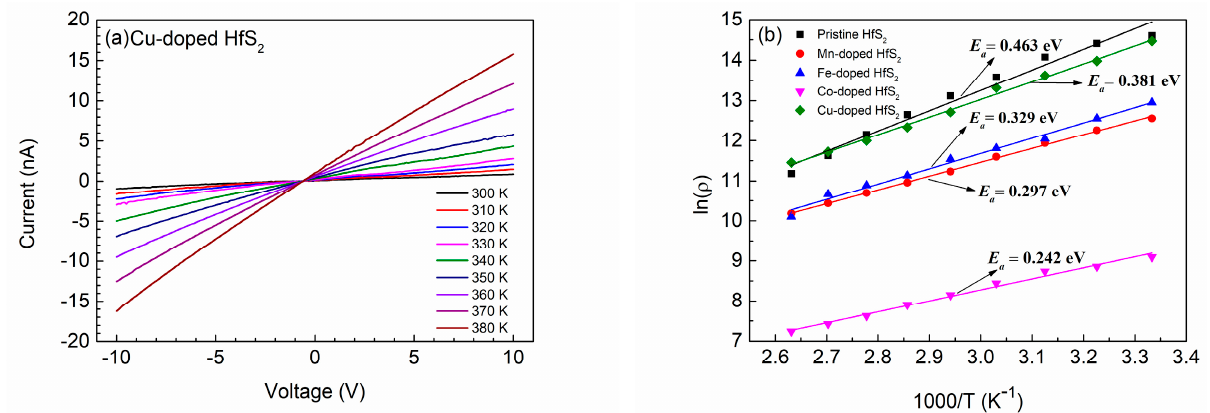
Figure 6. ( a )Temperature-dependent I-V curves of the Cu-doped HfS 2 crystal. ( b ) Plots of ln( ρ ) ver- versus 1000 /T of the pristine, Mn-, Fe-, Co-, and Cu-doped HfS 2 crystals. sus 1000 /T of the pristine, Mn-, Fe-, Co-, and Cu-doped HfS 2 crystals. temperature-dependent I-V curves. The curves of ln[ ρ ( T )] versus 1000/ T for the samples trons that transition from the donor level to the conduction band. The relationship be- are plotted in Figure 6b. As shown, the curve of each sample was approximately a straight tween resistivity ρ and temperature T can be expressed as [29,61–63] line, and the Co-doped HfS 2 crystal had the smallest ρ at any given temperature T. The